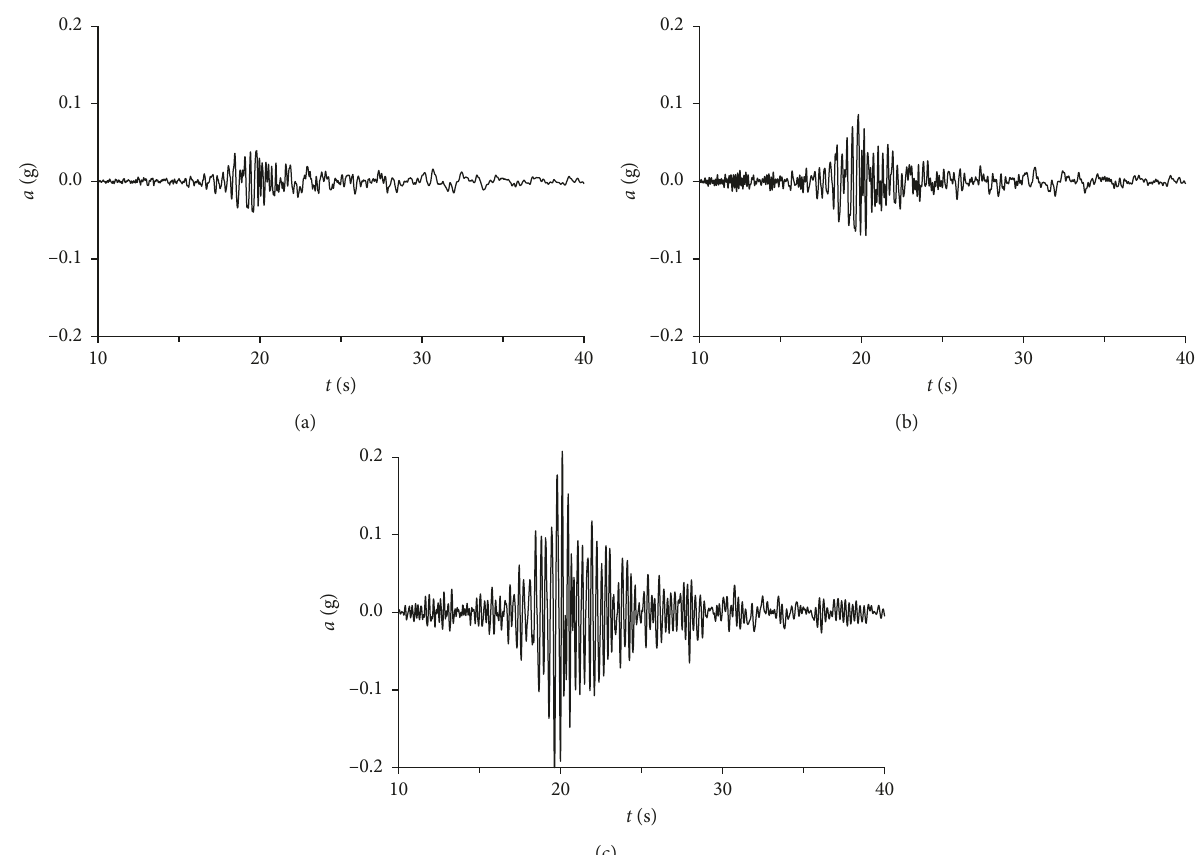
Figure 20: Accelerometric recordings obtained during the October 30, 2016, earthquake ( M basement, (b) at the first floor just above the isolation system, and (c) at the top of the building, respectively.